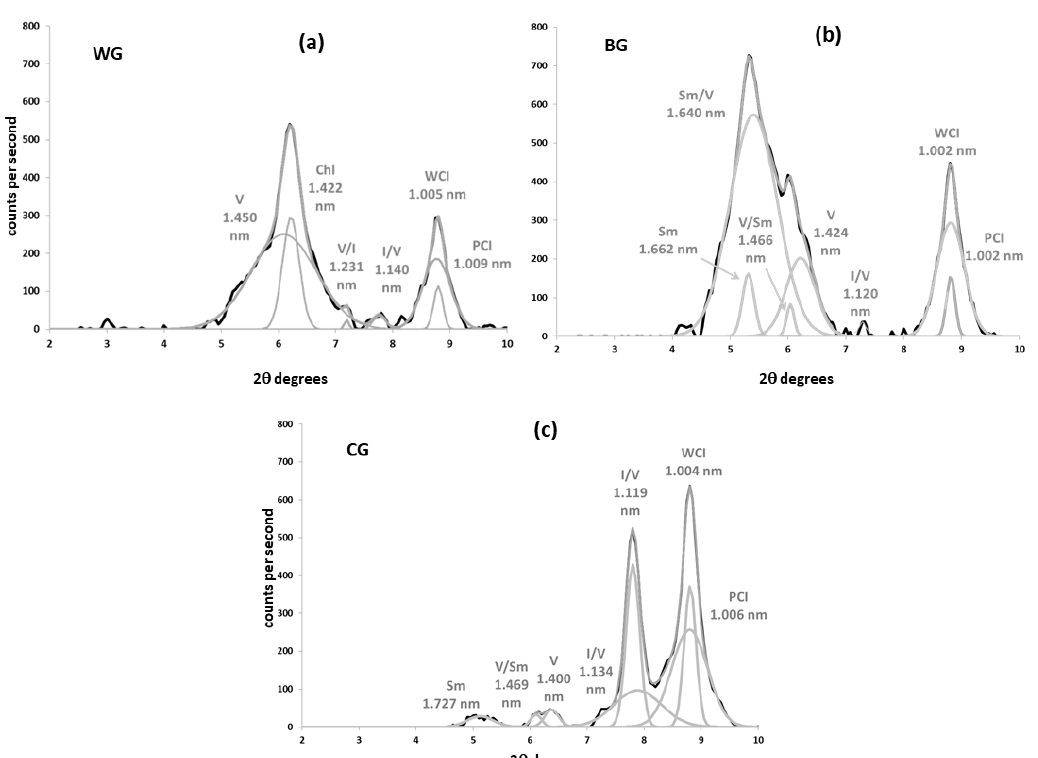
Figure 4. Peak decomposition of XRD patterns of oriented mounts (3 – 10° 2 θ ) from clay fraction of the siliceous soils (Mg-saturated and EG-solvated). Black: experimental pattern; Grey: simulated pattern. ( a ) Woodland soil over granodiorite (WG); ( b ) conventional soil over granodiorite (BG); ( c ) cover crop soil over granodiorite (CG). Sm: smectite; Sm/V: smectite – vermiculite mixed-layer; V/Sm: vermiculite–smectite mixed layer: vermiculite; V/I: vermiculite–illite mixed-layer;